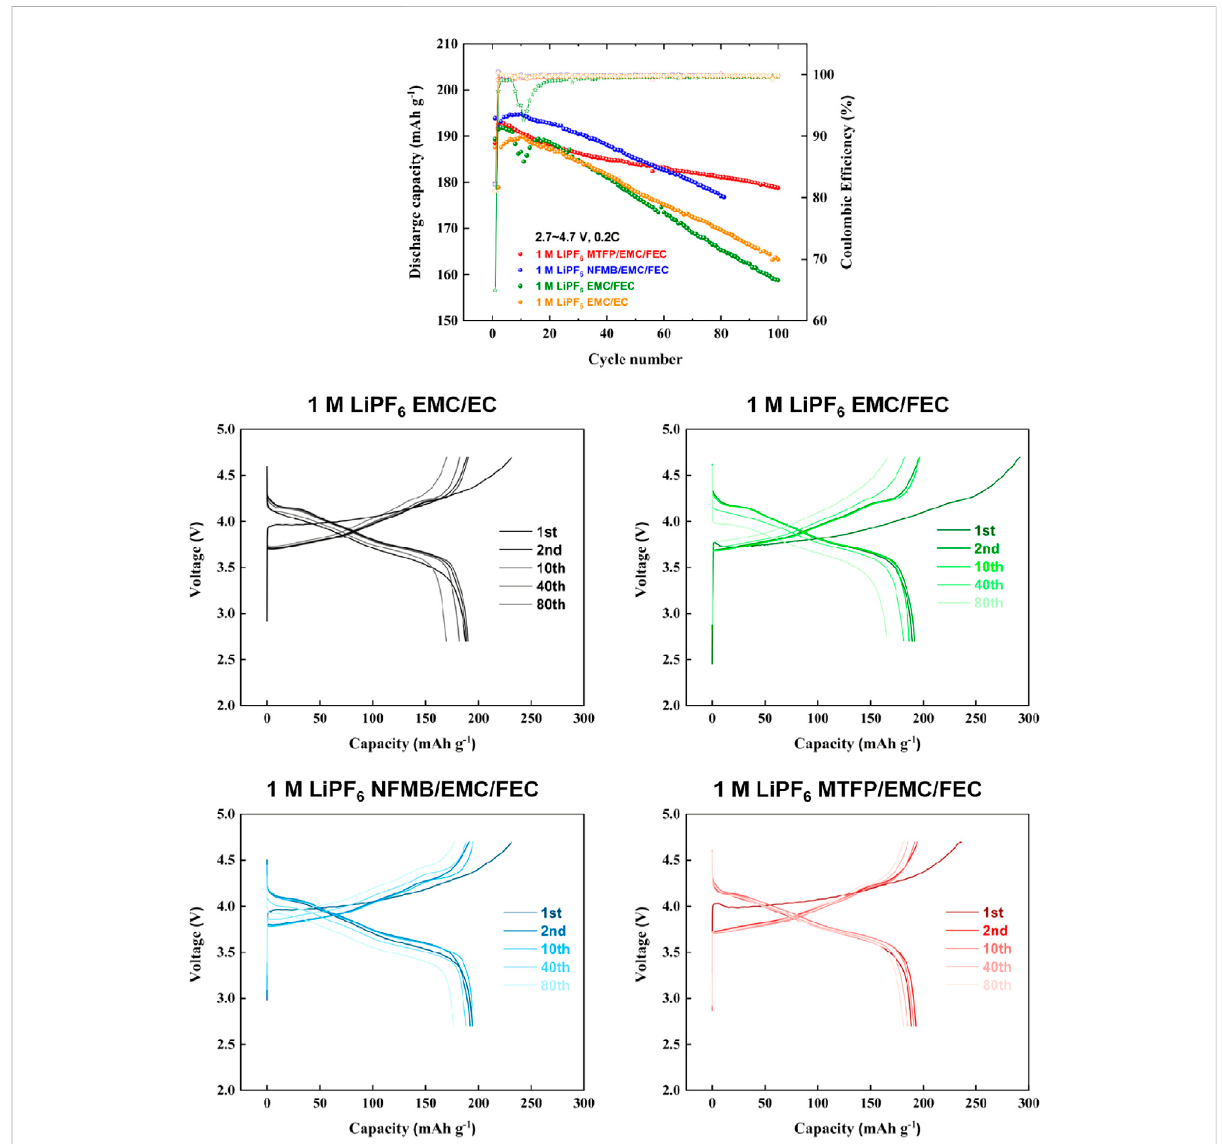
FIGURE 5 Charge-discharge cycling performances of Li/NCM811 coin-cells assembled with different electrolytes at a cut-off voltage of 2.7 – 4.7 V and a current density of 0.2